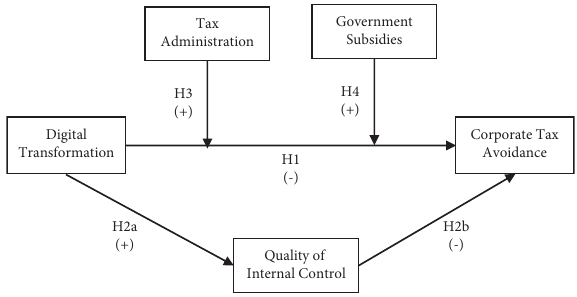
Figure 2: Teoretical analysis